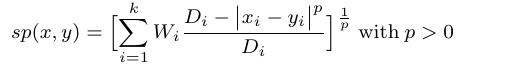
Figure 2: Formulation of 3D evidence grids and similarity map. (a) & (b) show the 3D point clouds ( P ( n p ) and P ( n p − 1) ) mapped onto an evidence grid of cell size L 3 respectively. In (c), the similarity map obtained from the two evidence